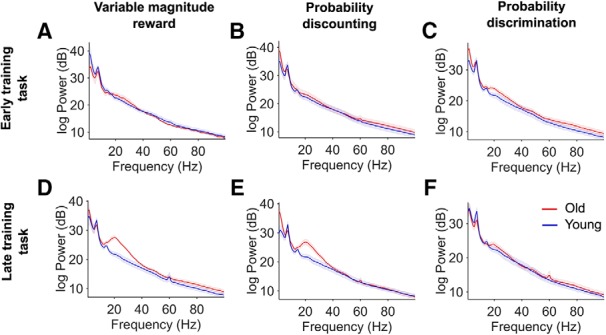
Task average power spectra in all young and aged rats, separated by training period. Each task is separated into a column, with the reward magnitude task (left), the probability discounting task (center), and the probability discrimination task (right). A–C, Spectrogram of the average LFP power during task (0.1–3.0 s after lever press), for the early training period. D–F, Same as A–C, for the late training period. The blue line corresponds to the power spectra in young rats and the red line corresponds to aged rats. Shading corresponds to SEM. Note the increased power in the β-band range in aged rats, for the late training period of reward magnitude and probability discounting tasks.